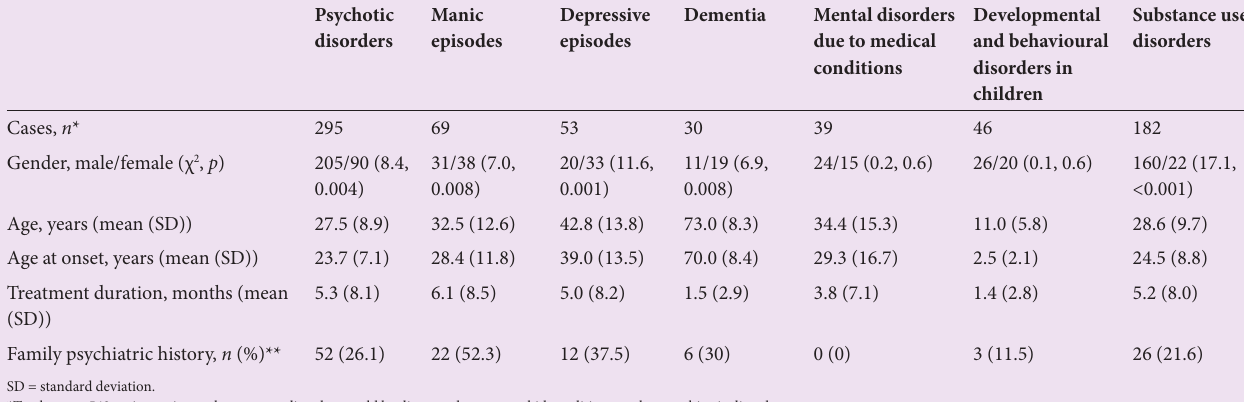
Table 2. Diagnoses established in the patients assessed in the mental health programme ( N